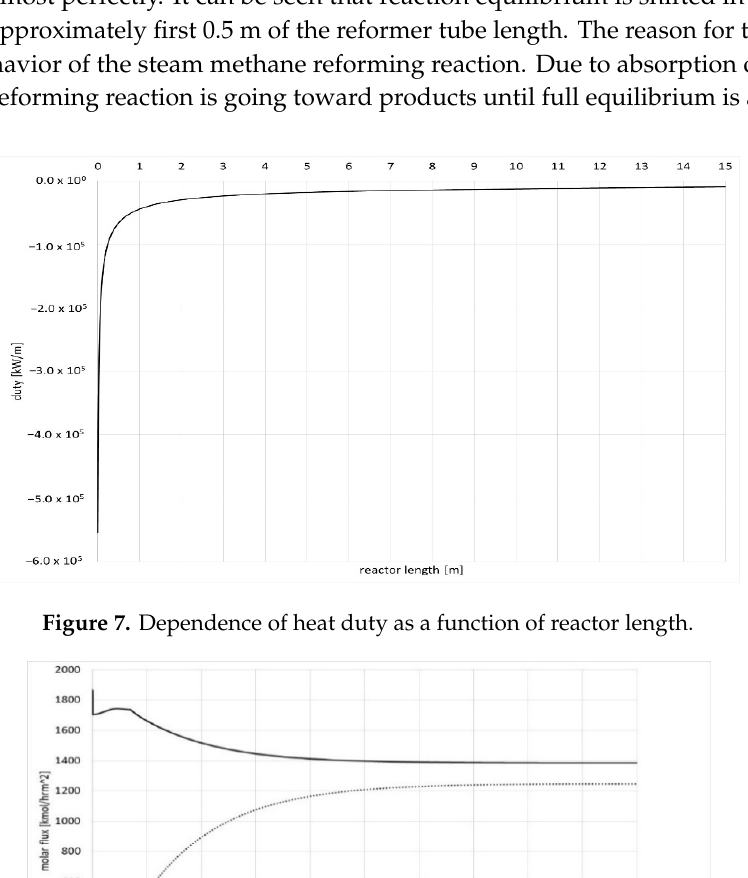
Figure 8. Molar flux profiles for the steam methane reforming reaction at given inlet process conditions from Table 3.